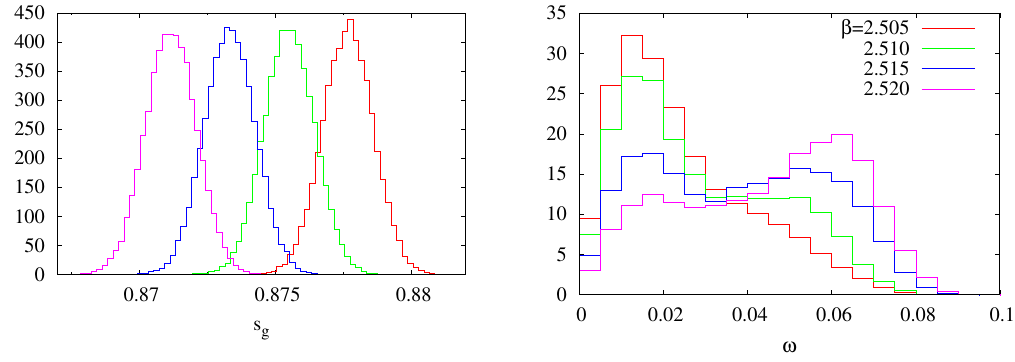
Figure 1 . The histogram of the action s g (left) and the modulus of the Polyakov loop ω (right) for the four